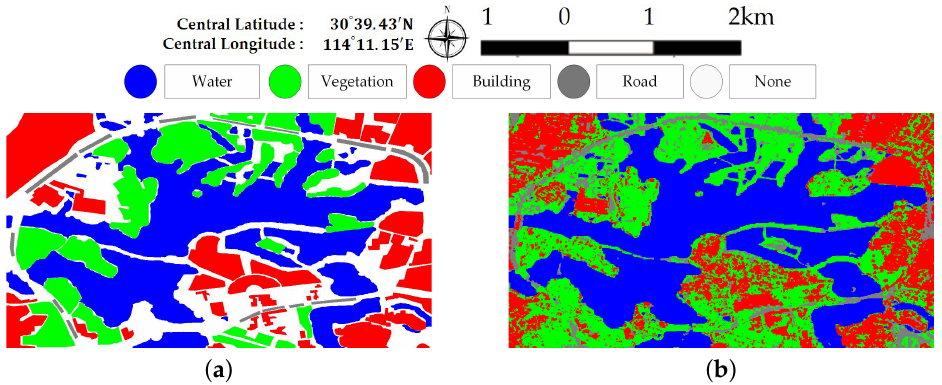
Figure 17. Ground truth map and final classification map of data set A with four classes. ( a ) Ground trup map. ( b ) Final classification